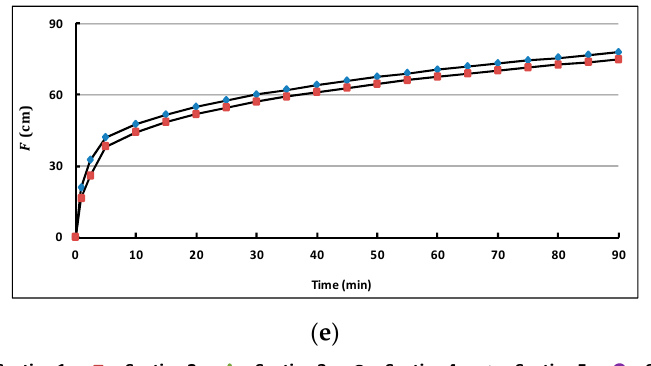
Figure 11. The values of cumulative infiltration F for different times for the five check dam design cases: ( a ) case 1; ( b ) case 2; ( c ) case 3; ( d ) case 4; ( e ) case 5. Table 4. The total inflow, outflow, and infiltration volumes after 90 min.